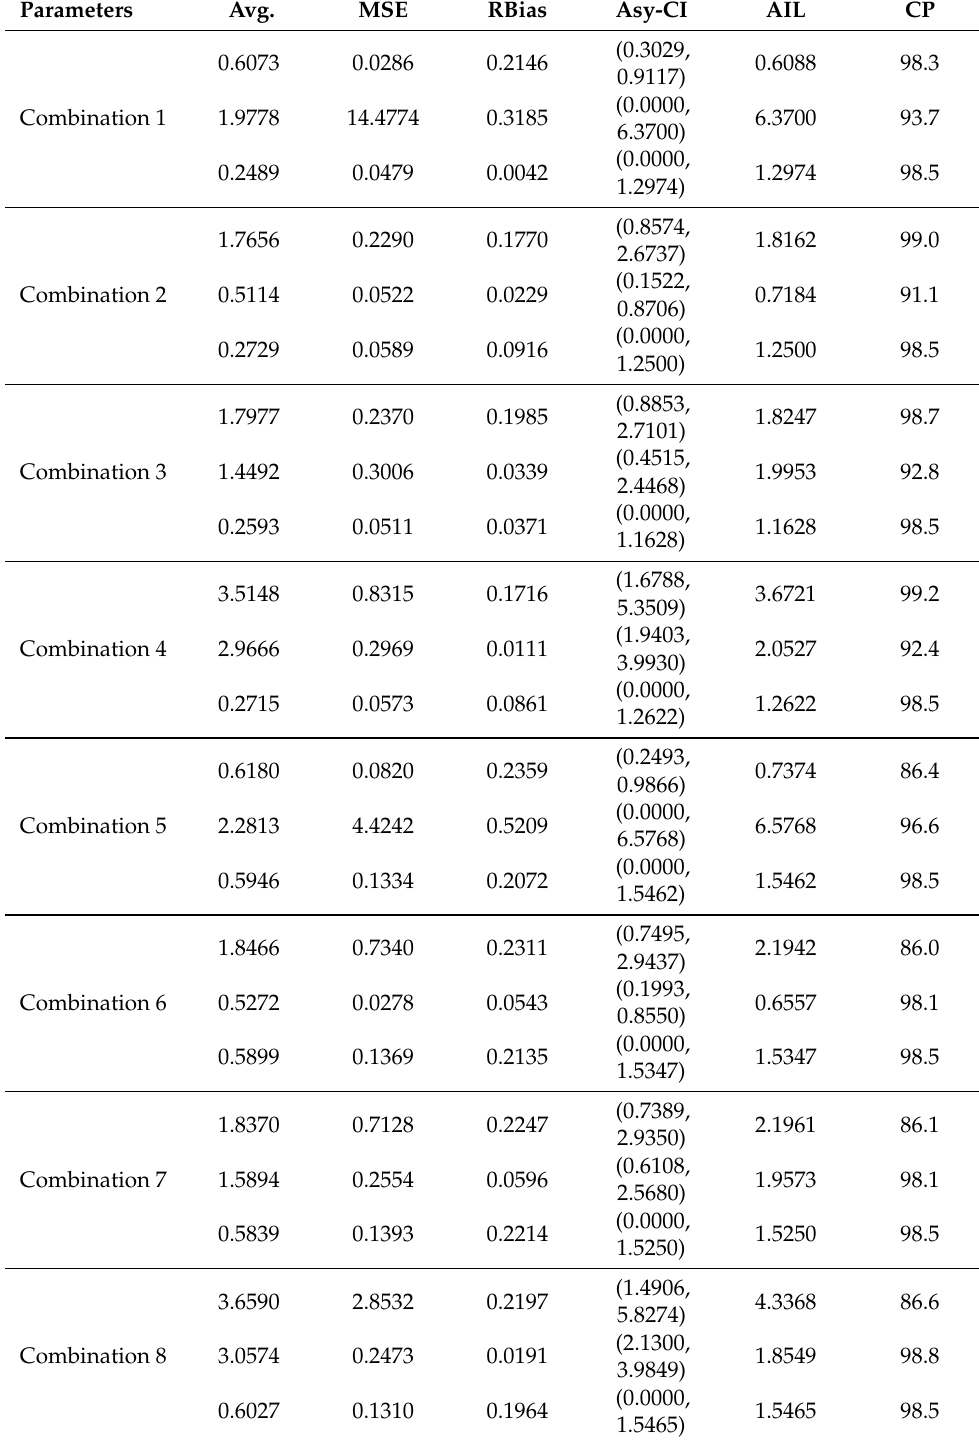
Table 7. Average estimated values, MSEs, CIs, AILs and CPs (in %) of the MLE for the FB distribution at N = 25 and n =